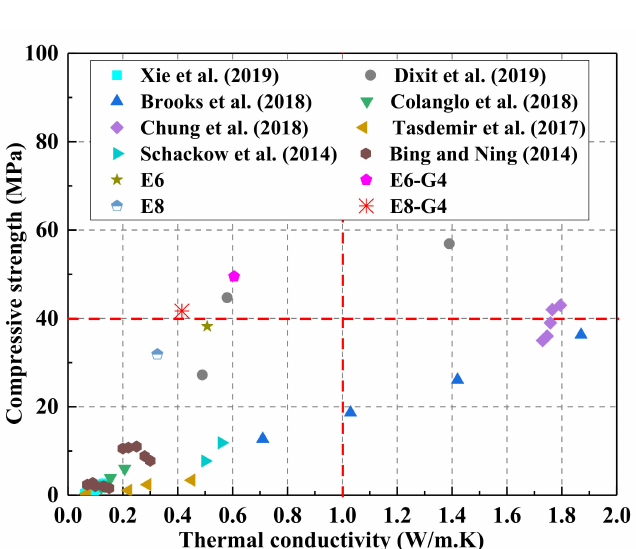
Figure 13. Contemporary works in the field of EPS insulating